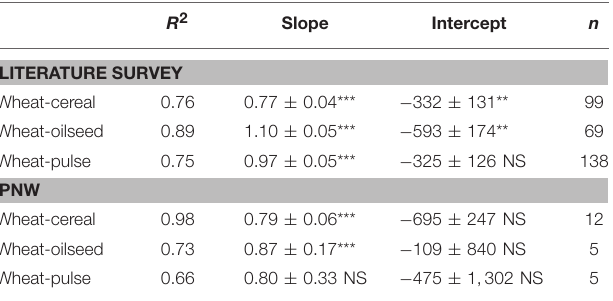
TABLE 4 | Regression parameters for the linear relationship between winter wheat yield following other cereals, oilseeds, or pulses and wheat following